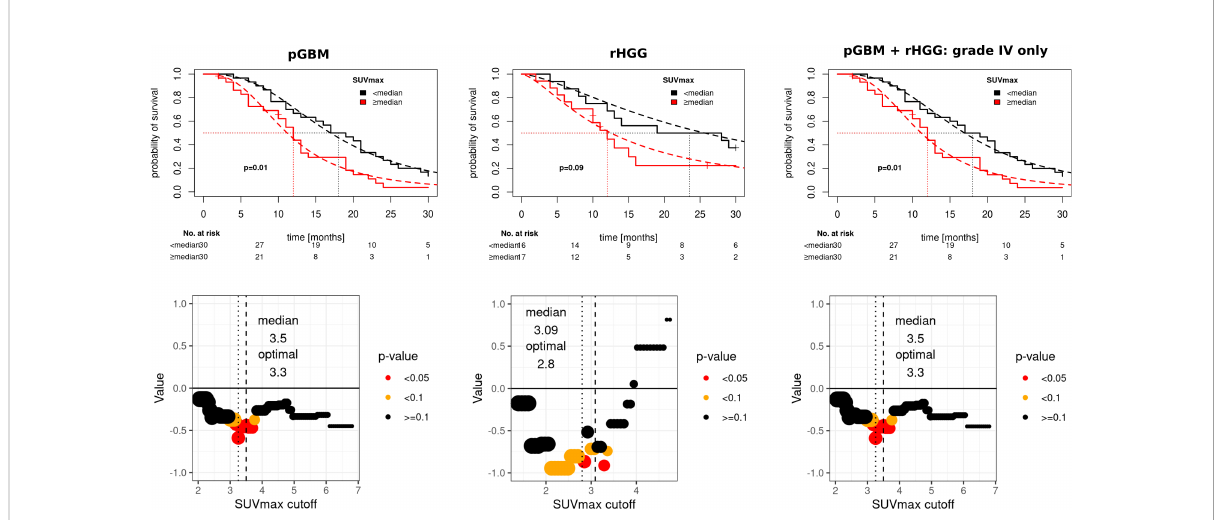
FIGURE 2 Prognostic value of SUVmax in pGBM and rHGG. Top row: Kaplan – Meier survival curves, log-logistic parametric survival regression fi ts (dashed line). Wald type p-value. Bottom row: model coef fi cients for varying cutoffs (bottom row), median (dashed line), and optimal cutoffs (minimal p- value, dotted line). pGBM, primary glioblastoma; rHGG, recurrent high-grade